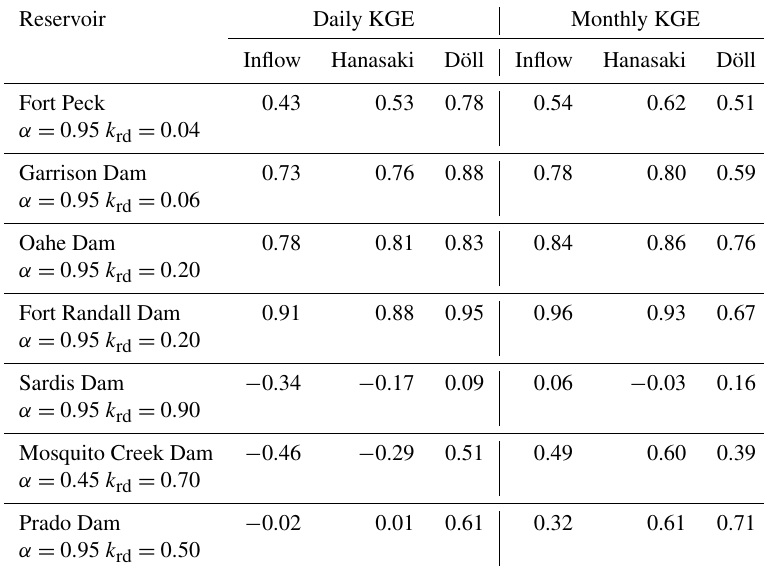
Table 3. Comparison of daily and monthly KGE values at selected reservoirs. The α and k rd values represent the highest KGE values for Hanasaki and Döll methods respectively.